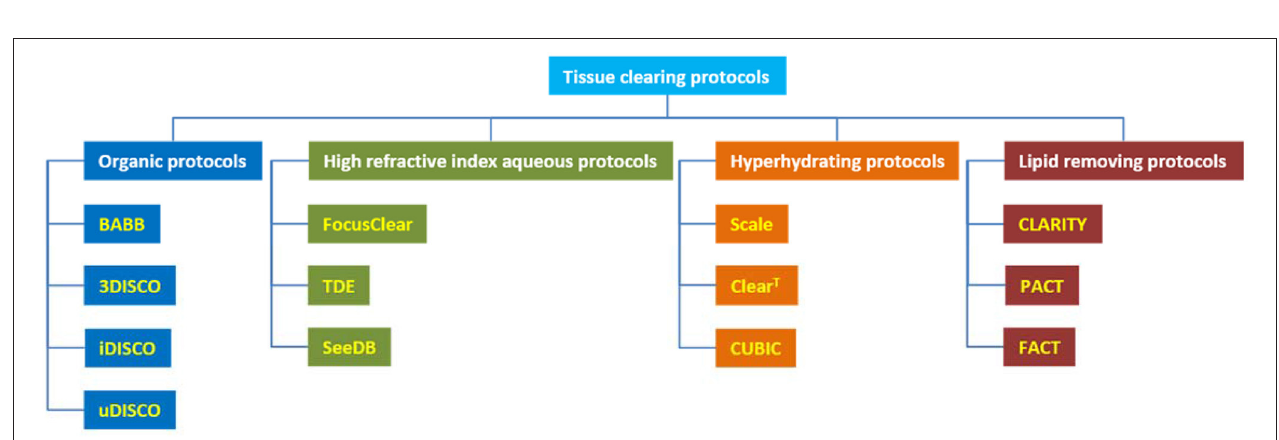
FIGURE 2 | Three-dimensional (3D) and two-dimensional (2D) imaging of different types of stem cells. (A) embryonic stem cells after immunostaining and 3D imaging by laser confocal microscope (with permission) (155). (B) embryonic stem cell on day 1 by 2D imaging using phase-contrast microscope (with permission) (156). (C) 3D image of mouse femoral bone marrow cleared with CUBIC and imaged by confocal microscopy (with permission) ( 38). (D) 2D imaging of bone marrow hematopoietic stem cells by intravital microscopy (with permission) ( 157). (E) 3D imaging of neural sphere stem cells with light sheet microscopy (with permission) (158). (F) 2D imaging of neurospheres with phase-contrast microscopy (with permission) (159).